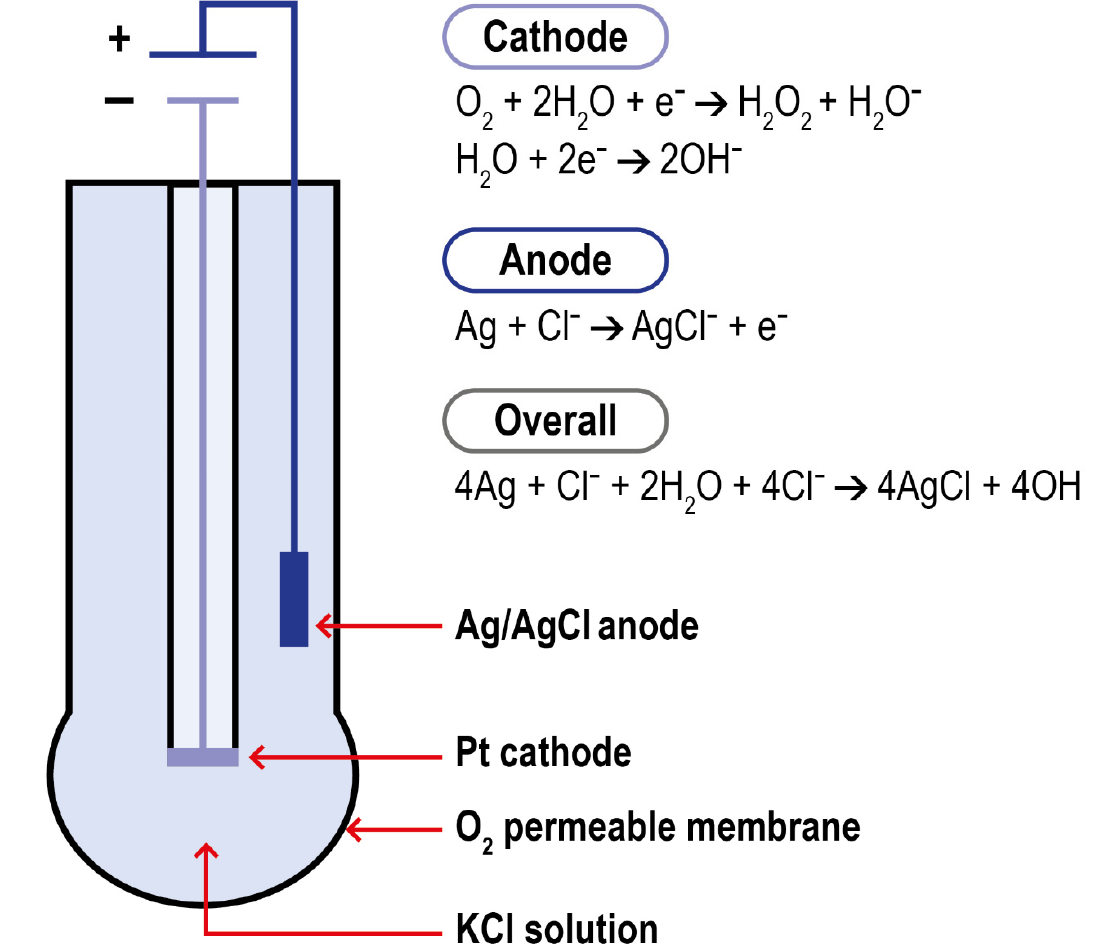
Figure 5. Schematization of Clark electrode and of the reactions in the Figure 5 . Schematization of Clark electrode and of the reactions in the system.